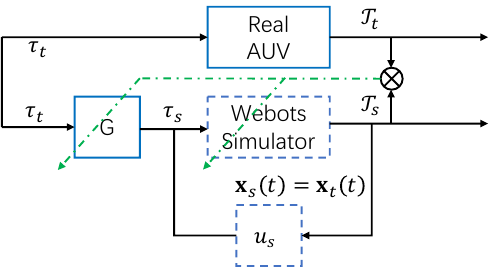
Figure 5. The Data-informed Domain Randomization (DDR) adaptation